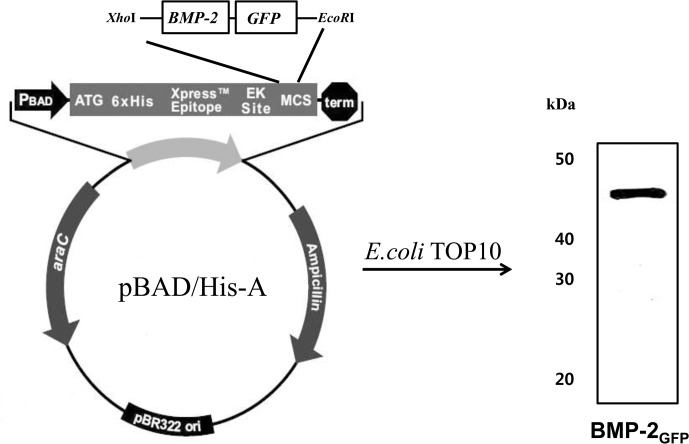
Schematic representation of the BMP-2GFP fusion proteins and Western blotting analysis of BMP-2GFP shown at 45 kDa.